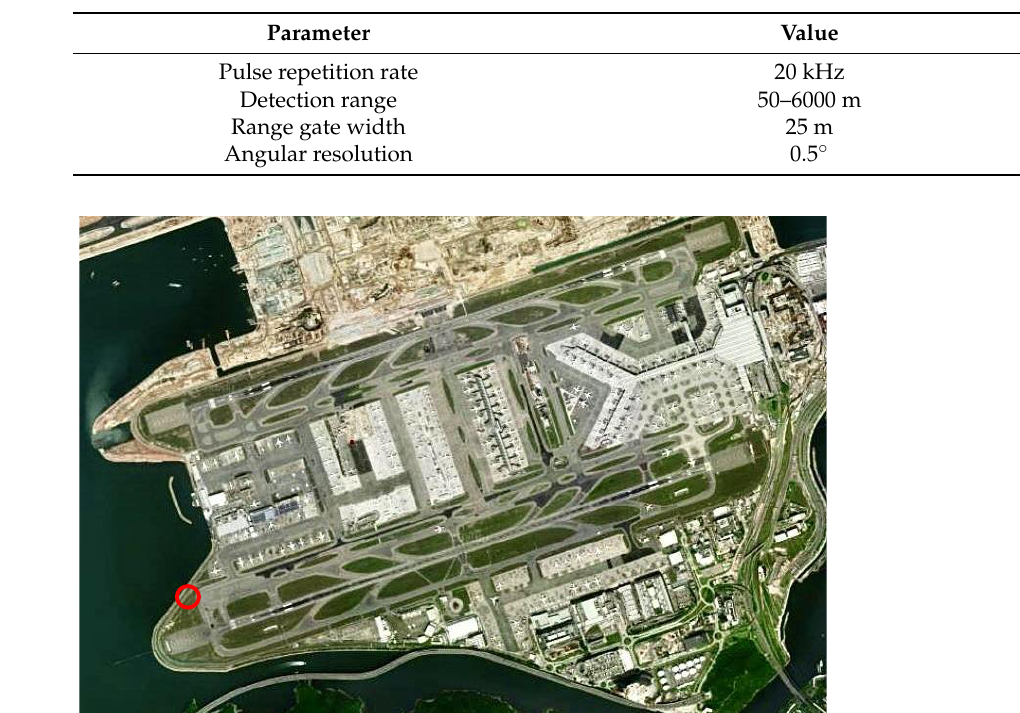
Table 1. Lidar parameters.